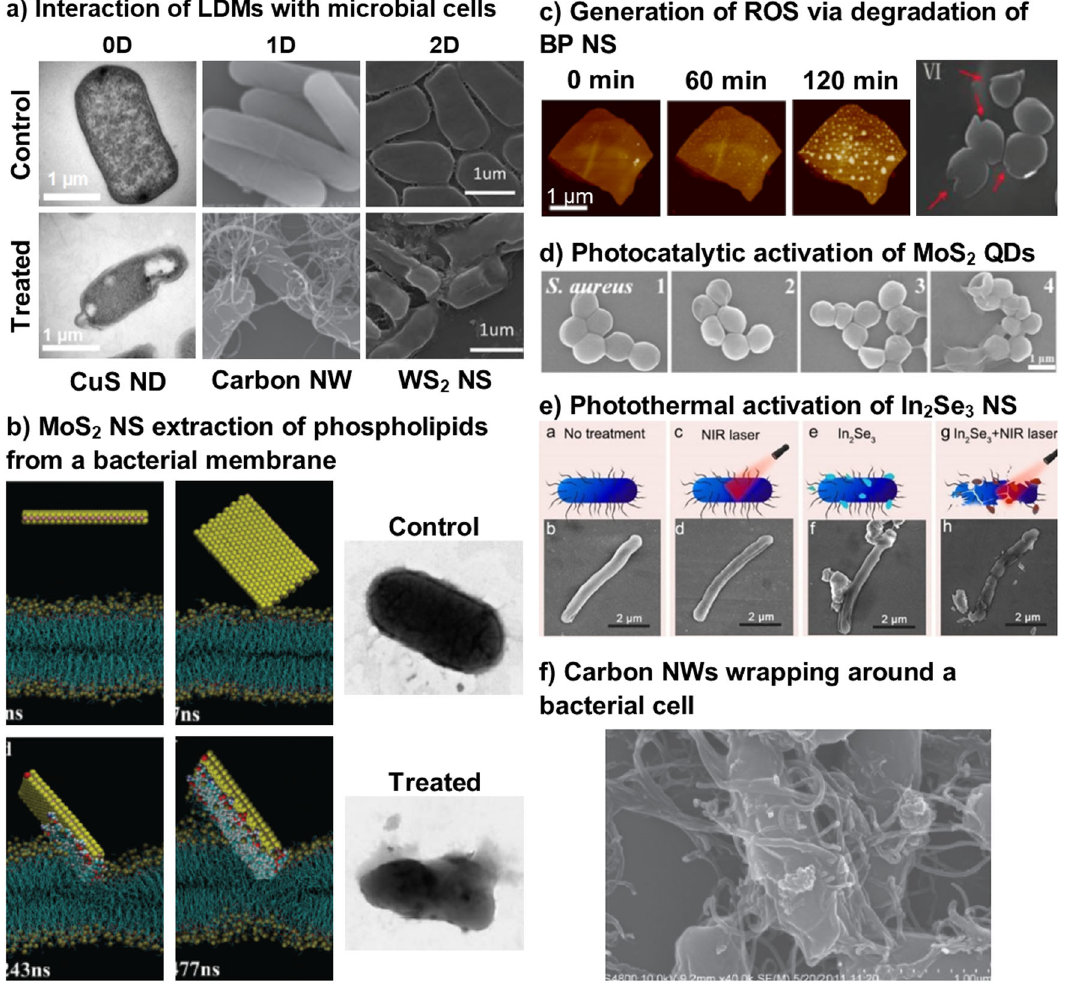
Fig. 4 Summary of antimicrobial interactions of LDMs in suspensions. a Interaction of suspended Copper sulphide (CuS) NDs with Escherichia coli (E. coli) 75 , carbon NTs wrapping around Lactobacillus acidophillus (L. acidophillus ) 56 and tungsten disulphide (WS E . coli 106 . b The extraction 2 ) NSs with mechanism of membrane phospholipids by MoS 2 NSs 63 . c Generation of ROS via degradation of BP NSs over 120 min (left) 217 and the interaction of Ti/BP NSs fi lm with S. aureus (right) with cellular damage indicated with red arrows 6 . d Photocatalytic activation of MoS 2 QDs against S taphylococcus aureus ( S. aureus) 74 and e the photothermal activation of indium(III) selenide (In E. coli 46 . f Carbon NWs wrapping around L. acidophillus 56 2 Se 3 ) NSs against